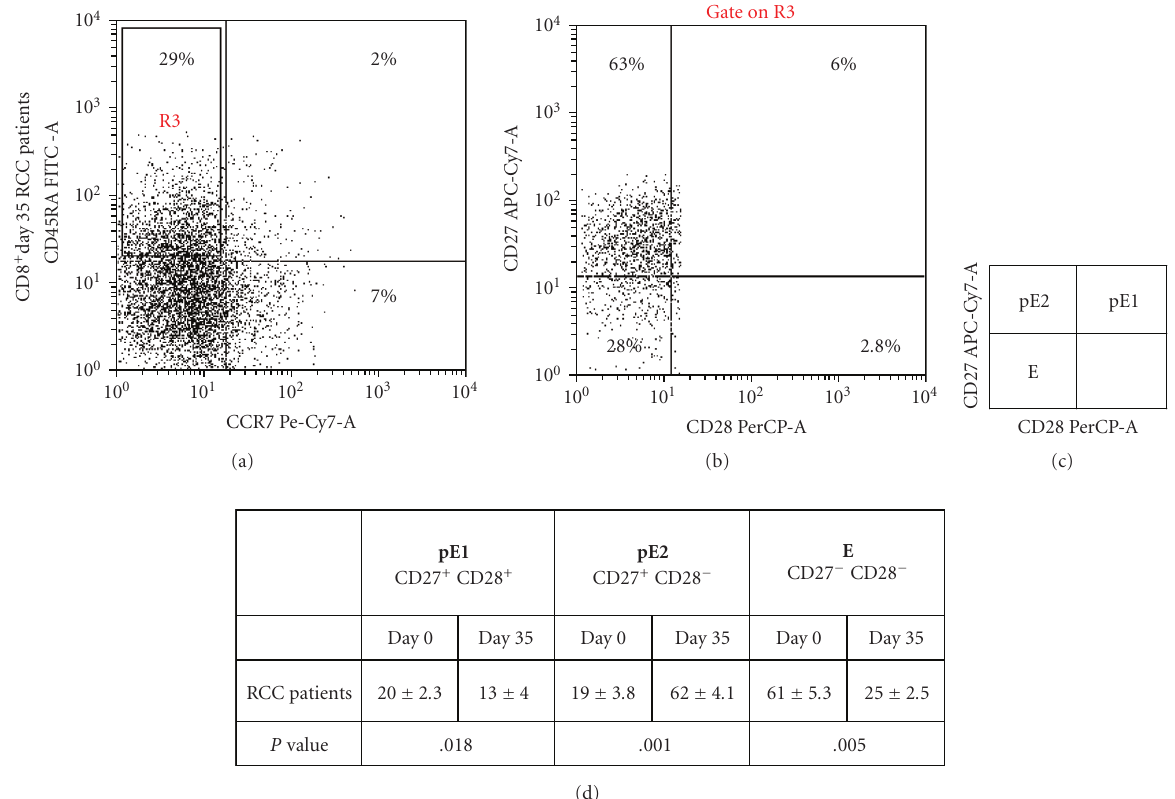
Figure 4: Characterization of the T EMRA population in RCC patients . Based on CD28/CD27 expression, CD8 + T cells were separated into three distinct populations: pE1 (RA + CCR7 − 27 + 28 + ), pE2 (RA + CCR7 − 27 + 28 − ), and E (RA + CCR7 − 27 − 28- ). Results are depicted for patients RCC2 but are representative of all 5 RCC patients